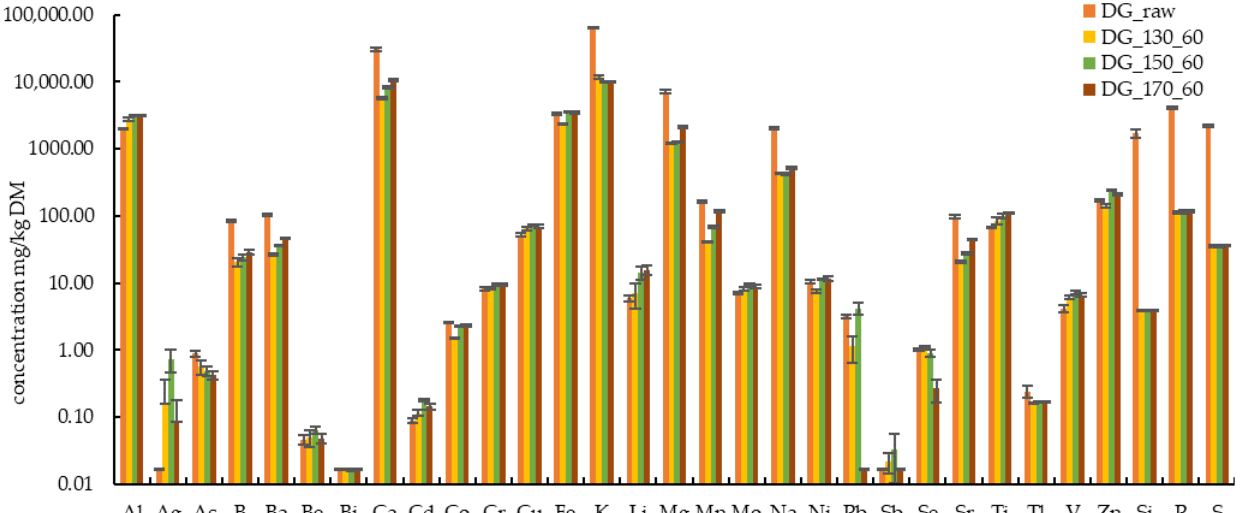
Figure 8. Dry matter (DM) based on mean values ± standard deviations of different elements for the raw and hydrothermally treated digestate (DG) at 130, 150 and 170 °C with a holding time of 60 min. Numerical values can be found in Appendix A.